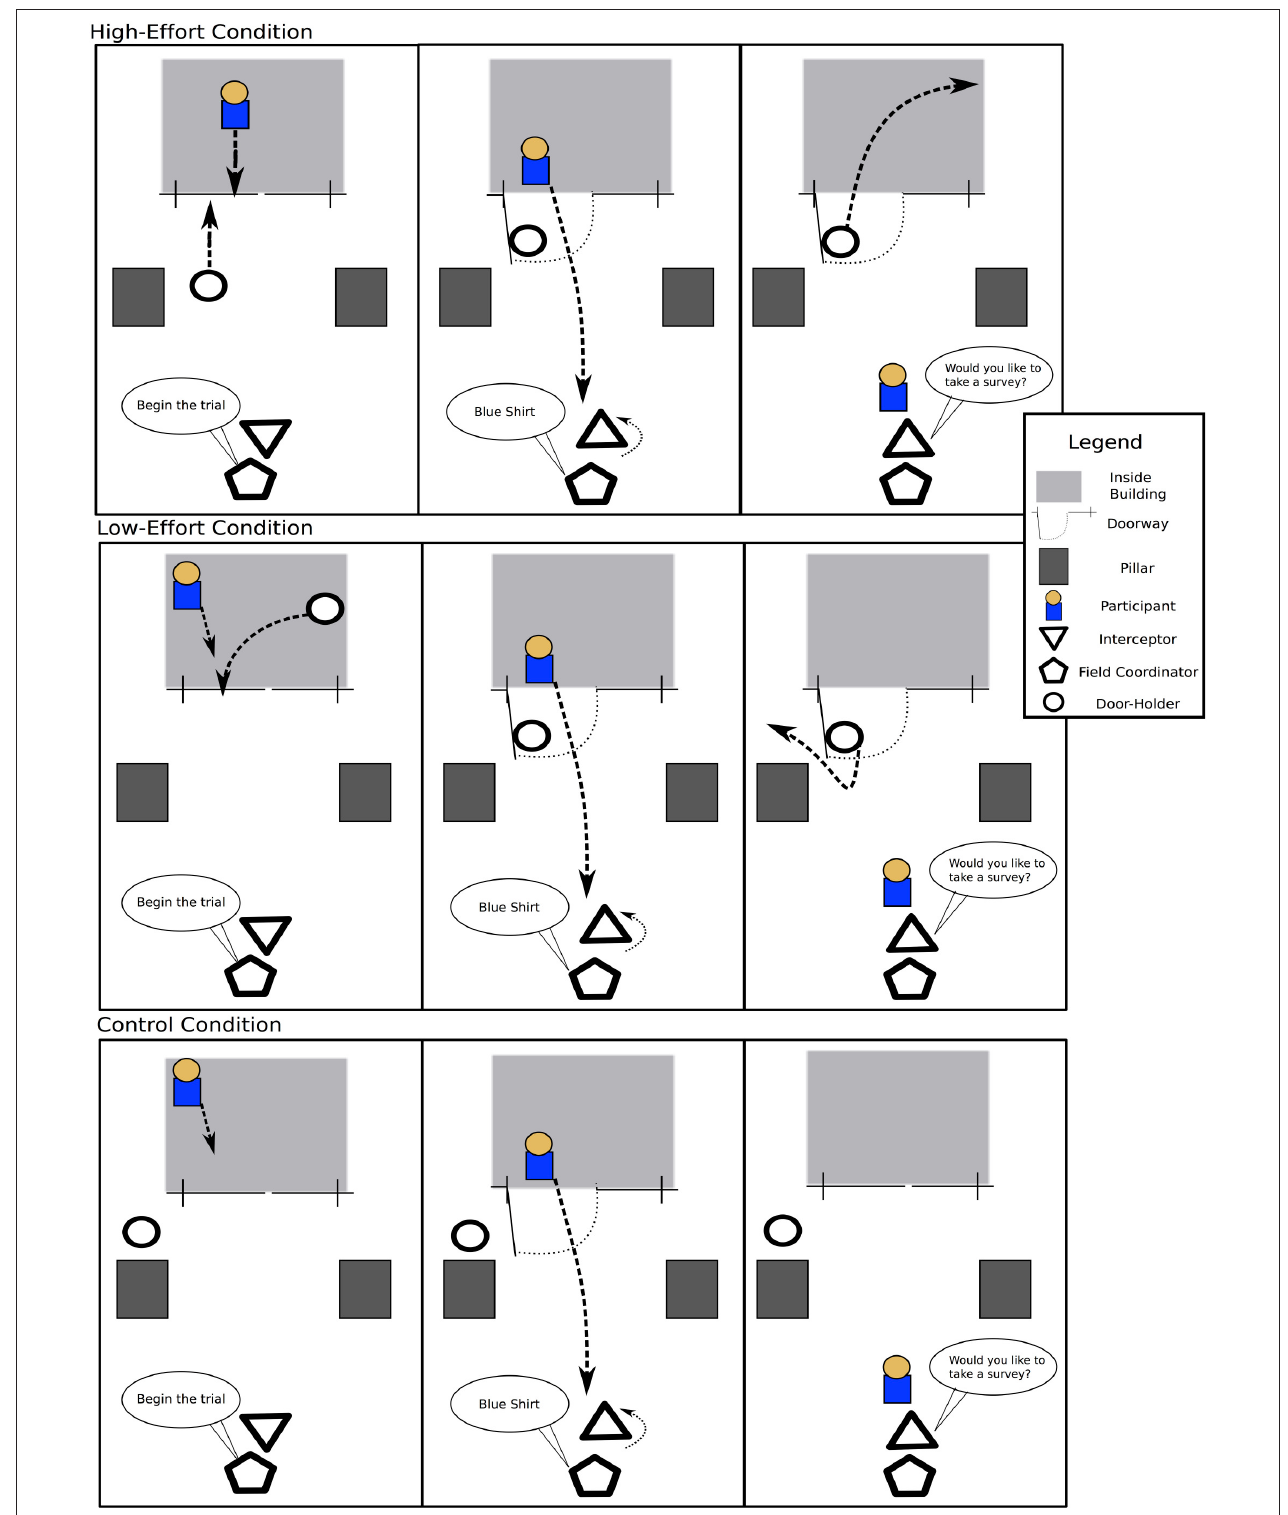
FIGURE 1 | Depiction of how trials were conducted in Study I. The panels depict the steps for a trial in the low- and high-effort conditions, respectively, moving left to right.